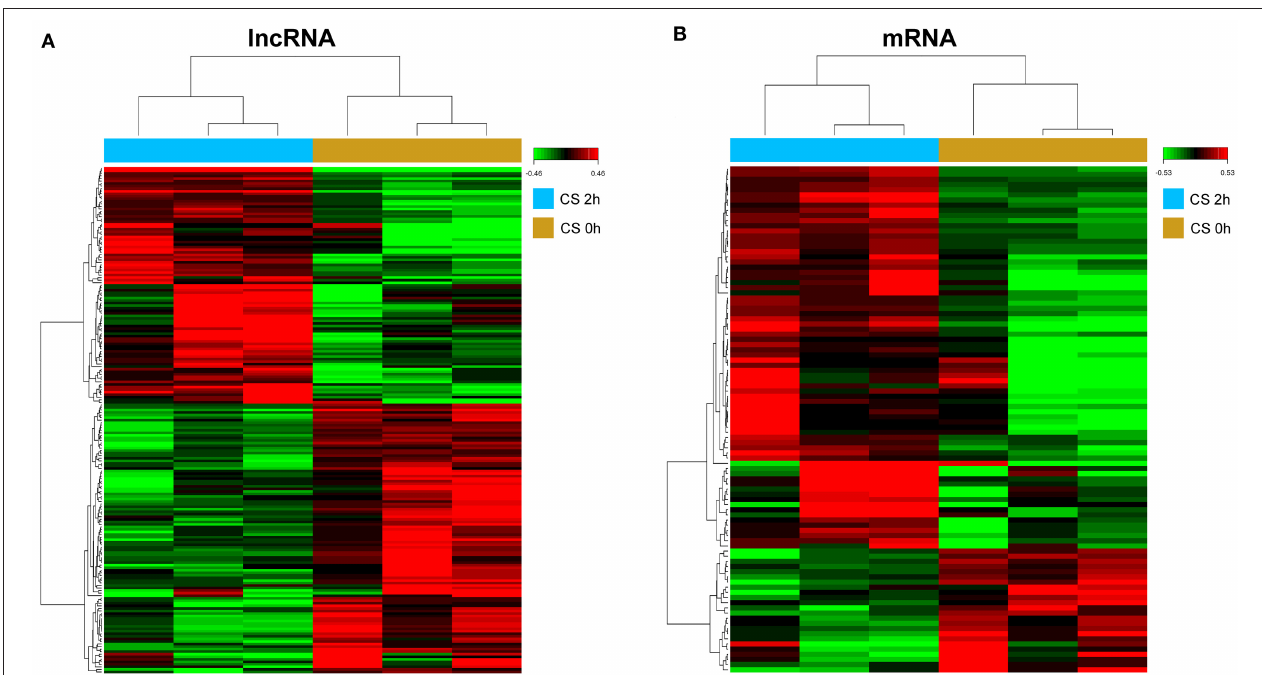
FIGURE 1 | Hierarchical clustering of differentially expressed lncRNAs (DELs) (A) and differentially expressed genes (DEGs) (B) . Red to green colors refer to be high to low relative expression levels.